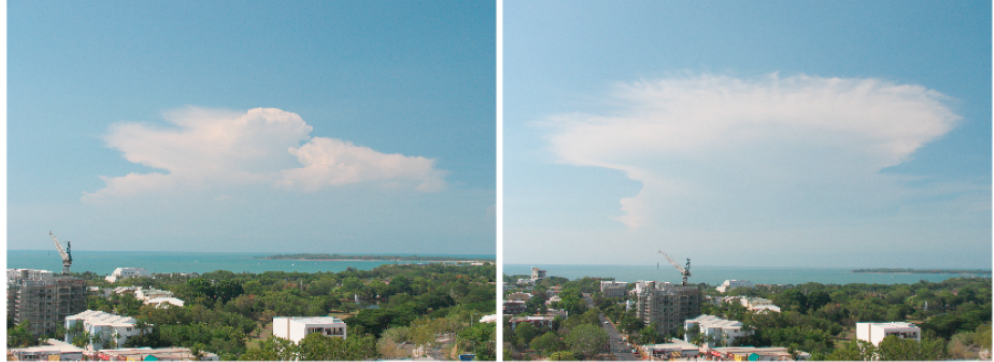
Fig. 2. Development of the Hector thunderstorm over the Tiwi Islands on 16 November 2005 during the SCOUT-O3/ACTIVE field campaign. From left to right, the photos indicate the stage of single-cell development at ∼ 16:19LT and ∼ 17:09LT,